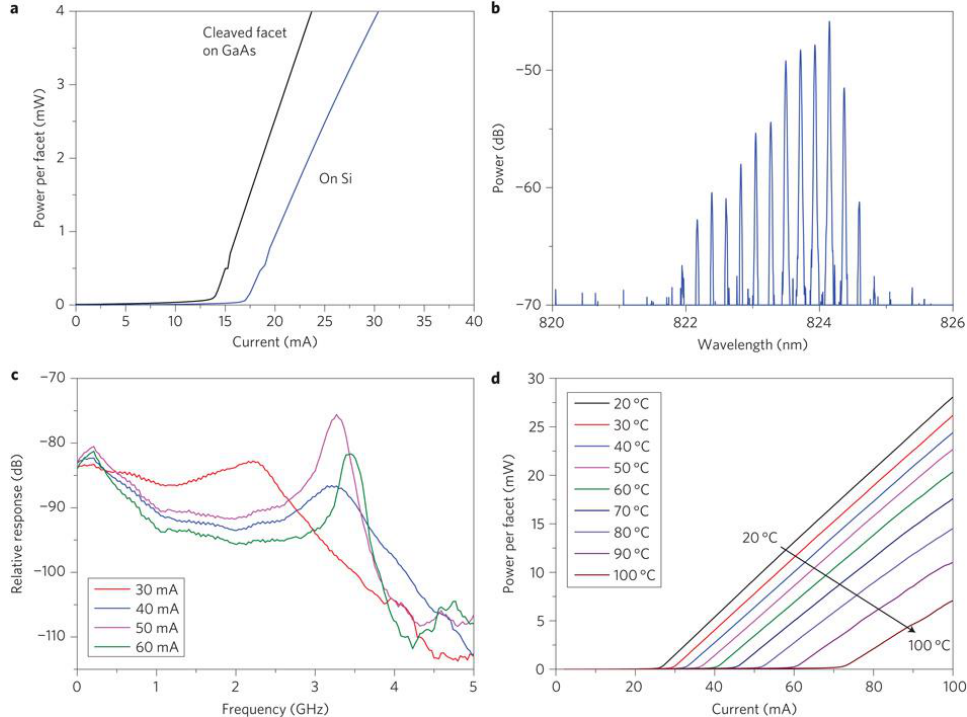
Figure 7. ( a ) Optical power as a function of current from a 3 µm-wide ridge, 370 µm-long laser fabricated on silicon, compared to a similar device fabricated using a standard cleaved facet on native GaAs substrate. ( b ) Spectrum of the laser showing the multiple longitudinal mode emission. ( c ) Small signal modulation response of the laser on silicon as a function of operating current from 30–60 mA. ( d ) Temperature dependence of the output power as a function of current from a 6 µm-wide ridge, 370 µm-long laser fabricated on silicon (reprinted from [38]).